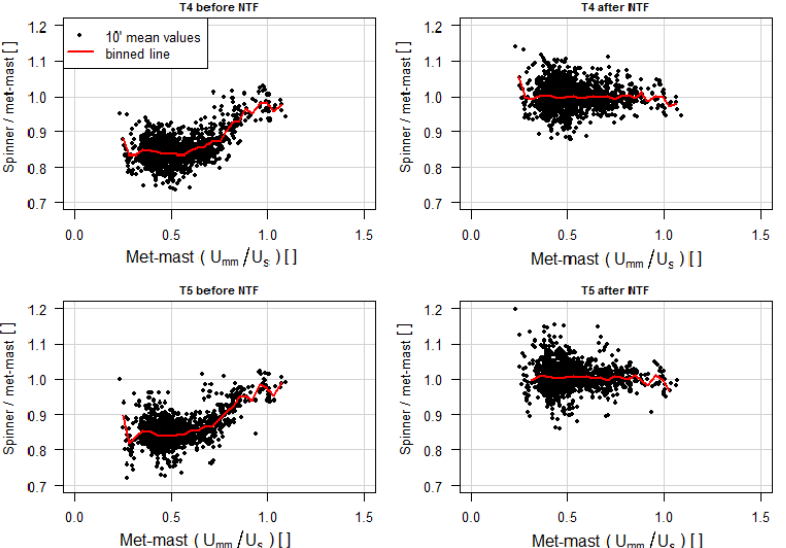
Figure 9. Ratio between calculated free wind speed and measured free wind speed ( U free /U mm ) as a function of measured free wind speed ( U mm ). Upper left: wind turbine 4 before application of the NTF. Upper right: wind turbine 4 after application of the NTF. Lower left: wind turbine 5 before application of the NTF. Lower right: wind turbine 5 after application of the